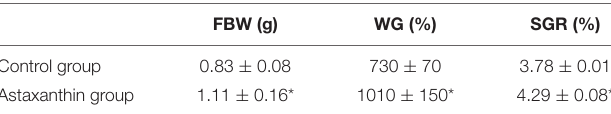
TABLE 3 | Exopalaemon carinicauda growth performance following experimental diet feeding for 56